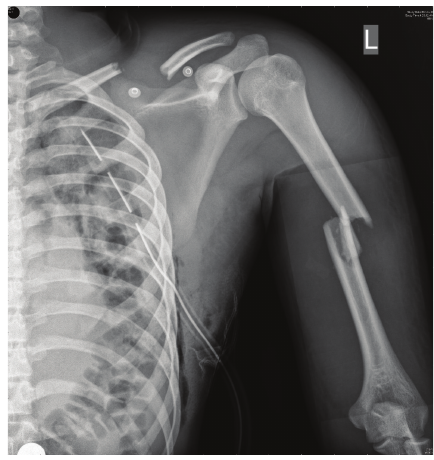
Figure 1: Plain radiograph showing a displaced fracture of clavicle and comminuted fracture shaft of humerus.